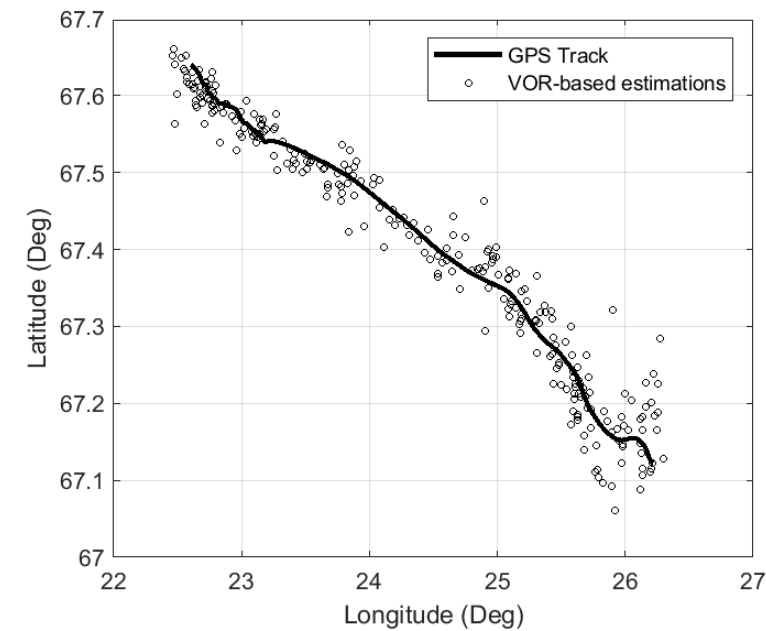
Figure 6. VOR-based track from SDR data compared to the GPS track.